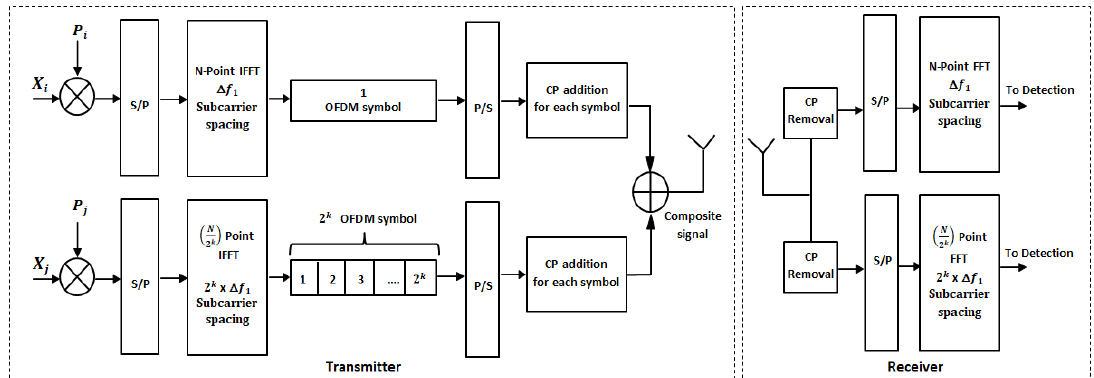
Fig. 1. Block diagram representation of multi-numerology scheme